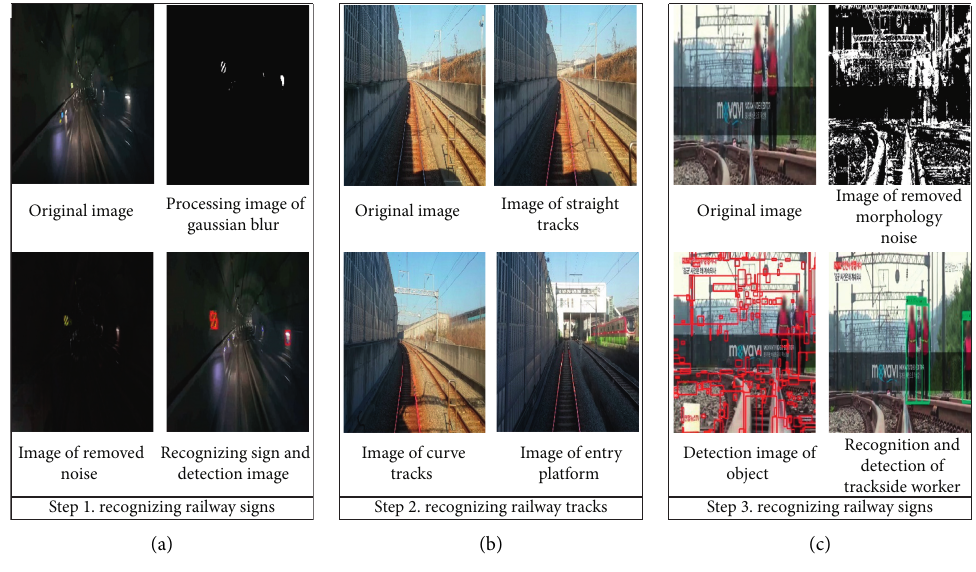
Figure 5: Application of algorithm to image data. Table 1: Definition of precision and